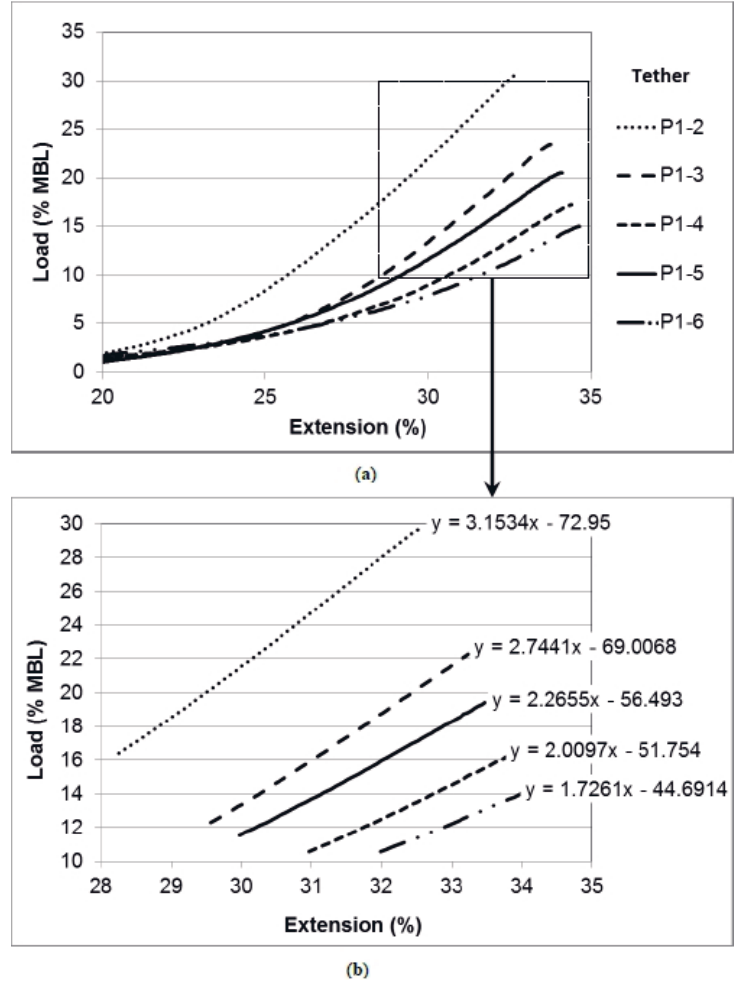
Figure 11. ( a ) P1 series tether extension properties from a 1550 N pre-tension datum; and ( b ) data clipped to achieve a R 2 0.9995 linear